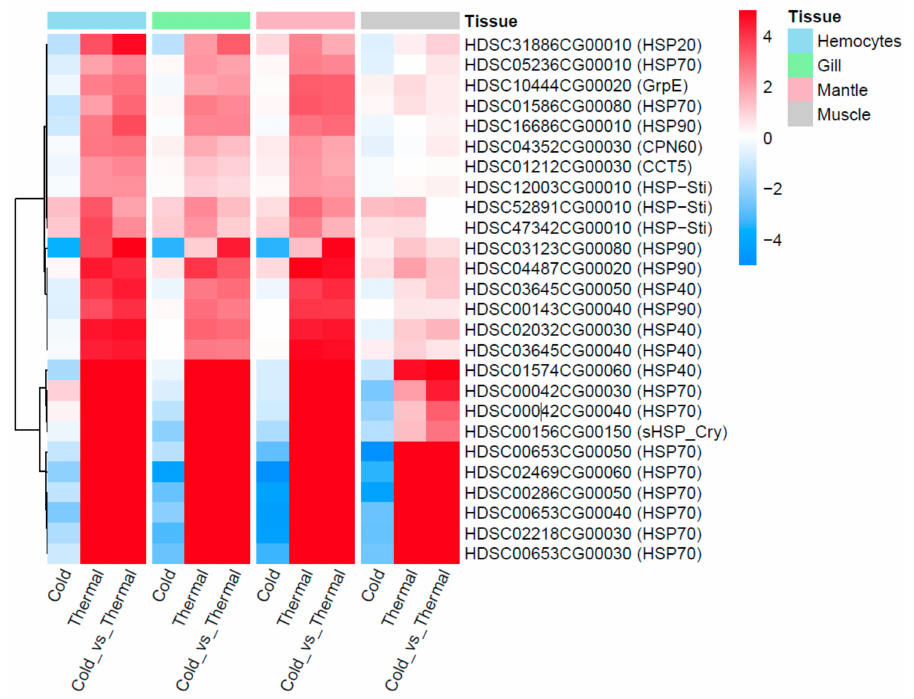
Figure 5. Twenty-six di ff erentially expressed HSPs observed from four di ff erent tissues and three temperature conditions (cold, optimal and thermal).